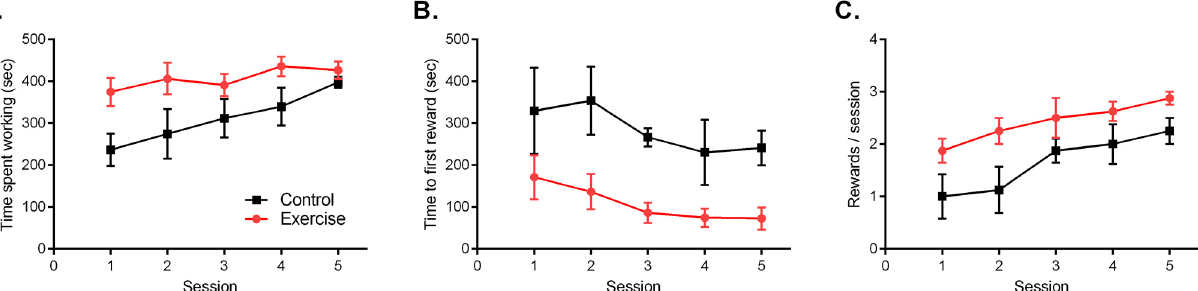
Fig 4. Toy Task. A) Across the five 10-minute sessions, the Exercise group spent more time working to remove food reward as compared to Control. B) The Exercise rats were quicker to obtain their first reward and (C) obtained more rewards over the course of the five day testing period as compared to Control. Data are shown as mean ± SEM; for each group n =